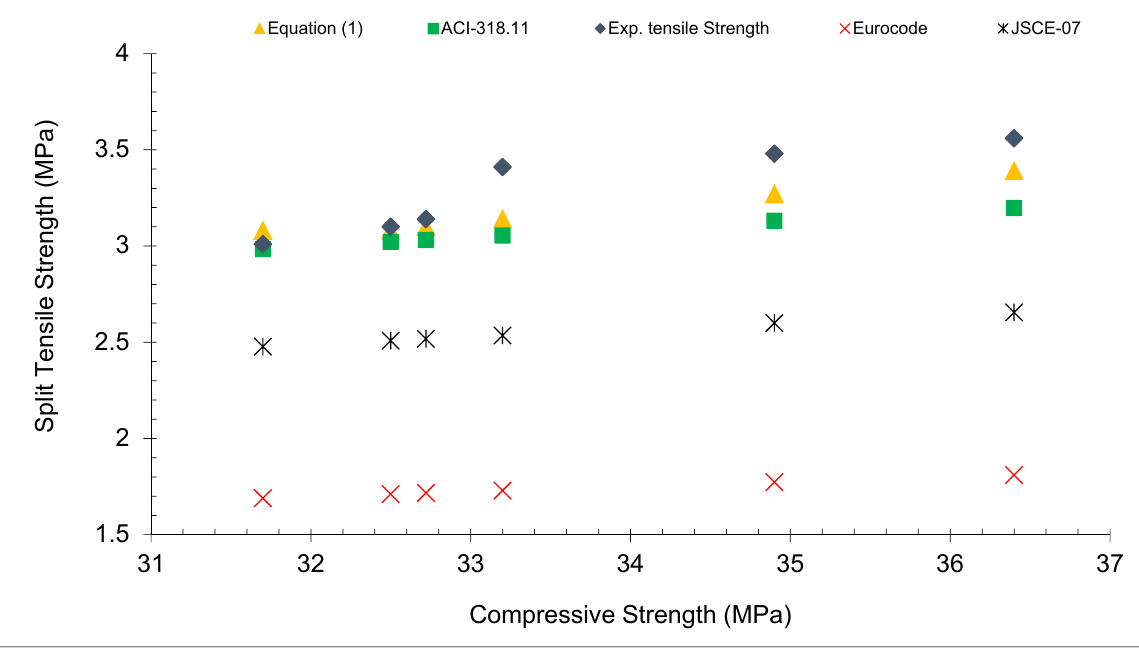
Figure 9. Experimental and predicted tensile strength.